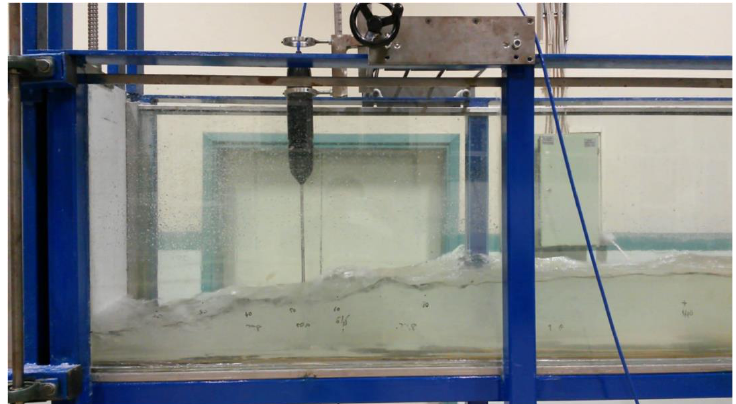
Figure 2. Snapshot of the experimental set-up. A supplementary video file is available for the animation of the experimental study.